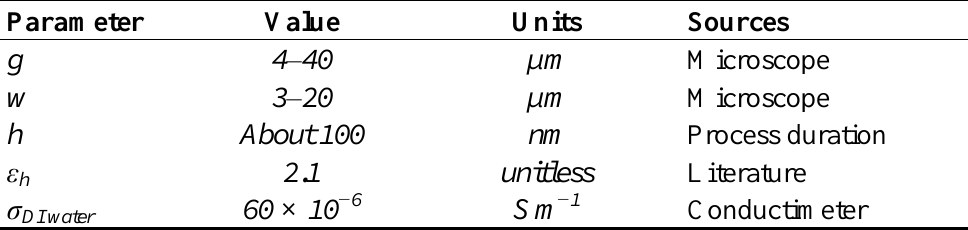
Table 2. Parameters values used for LDEP actuation